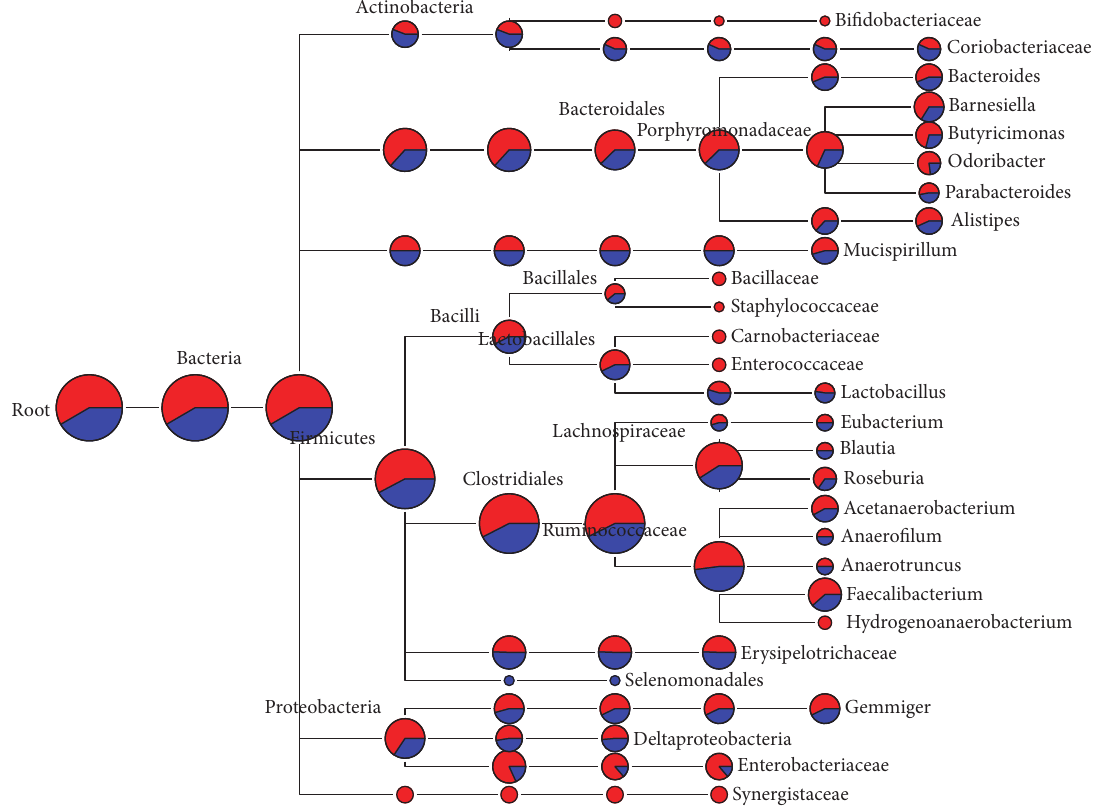
Figure 1: Bacterial diversity of chicken cecal content bacteriome. Only the genera represented by ≥ 5 OTUs each were shown, and the size of each node reflects the total number of OTUs. The relative proportion of taxa from the two pyrosequencing runs was shown by different colors: red, from the first run; blue, from the second run.